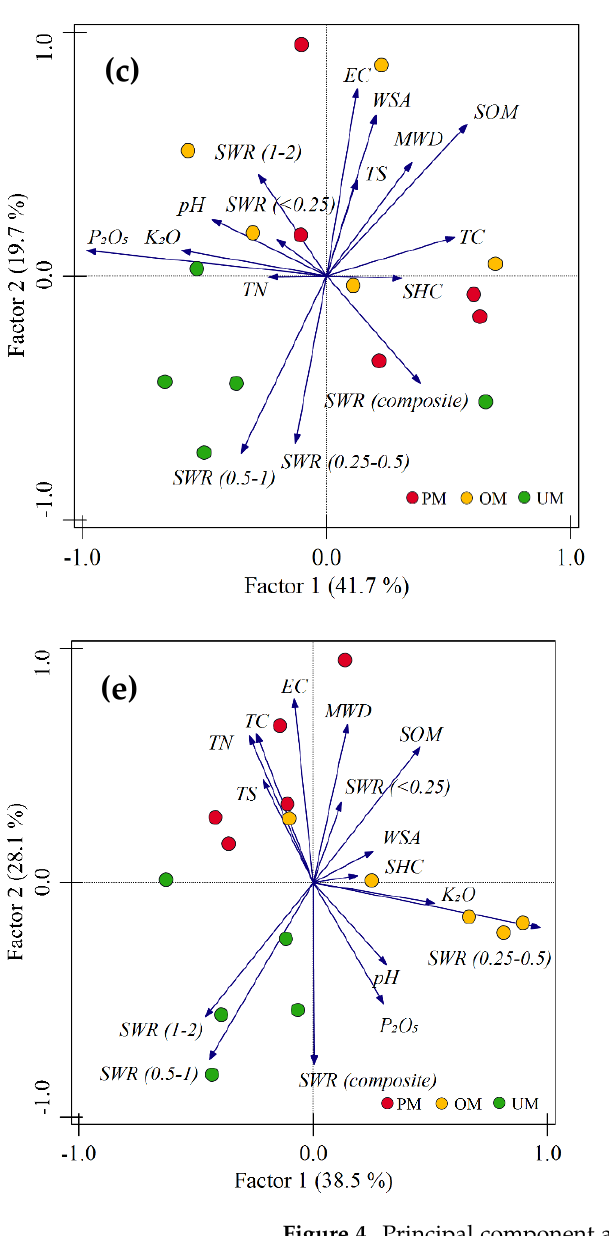
Figure 4. Principal component analysis for the relation between Factors 1 and 2 for six sampling dates. Soil water repellence (SWR; fraction values are expressed in mm), soil hydraulic conductivity (SHC), mean weight diameter (MWD), water stable aggregates (WSA), electrical conductivity (EC), soil organic matter (SOM), total sulphur (TS), total carbon (TC), total nitrogen (TN), pine mulch (PM), olive mulch (PM), and unmulched (UM) treatments: ( a ) 25 days after fire; ( b ) 3 months after fire (MAF); ( c ) 6 MAF; ( d ) 9 MAF; ( e ) 12 MAF; ( f ) 15 MAF.